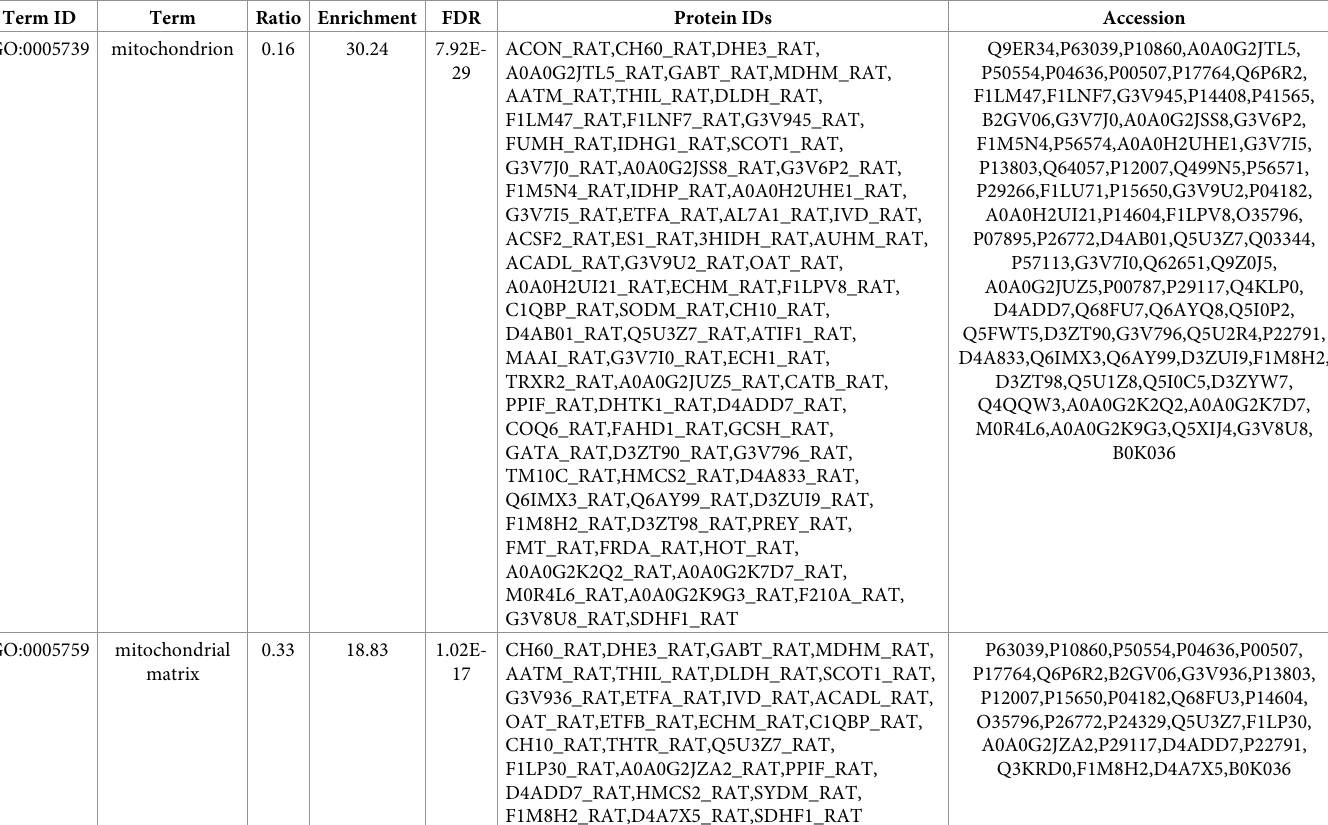
Table 3. The significantly enriched GO terms related to cellular component.